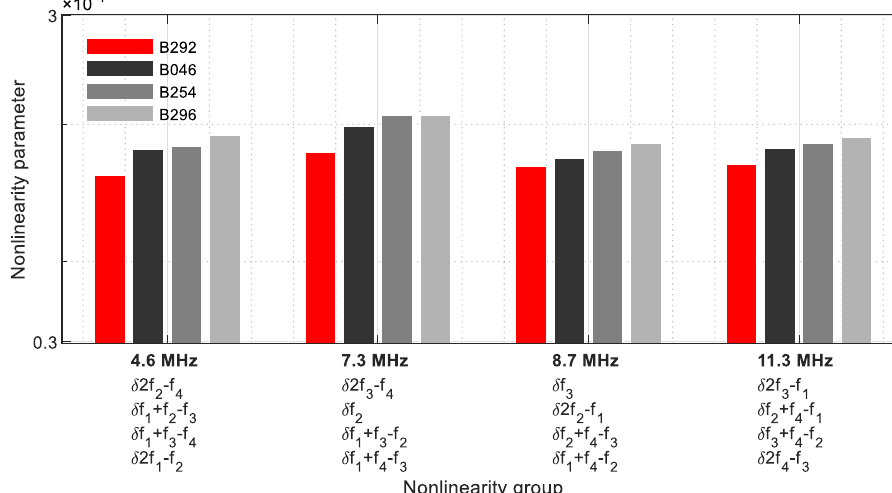
Figure 34. Nonlinearity parameter — δ G3 .